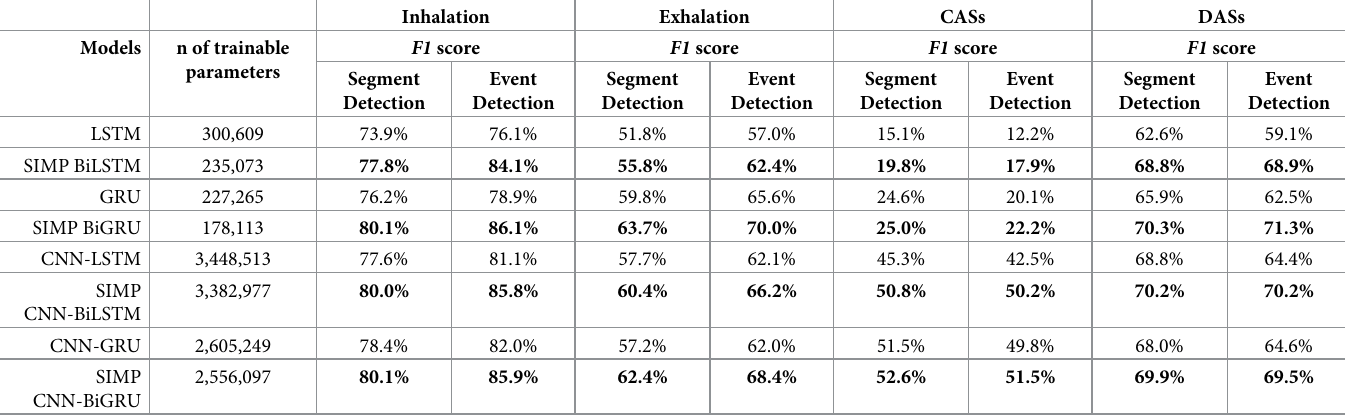
Table 5. Comparison of F1 scores between the unidirectional and bidirectional models.